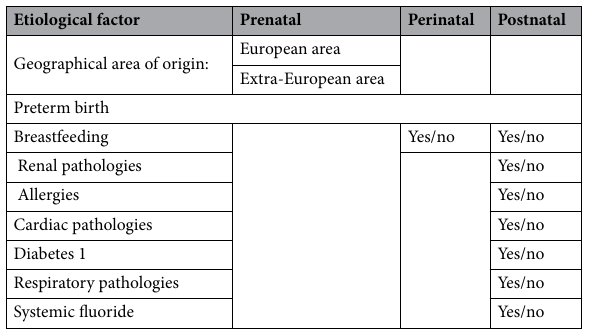
Table 7. Possible etiological factors collected during the survey from the questionnaire fulfilled by the